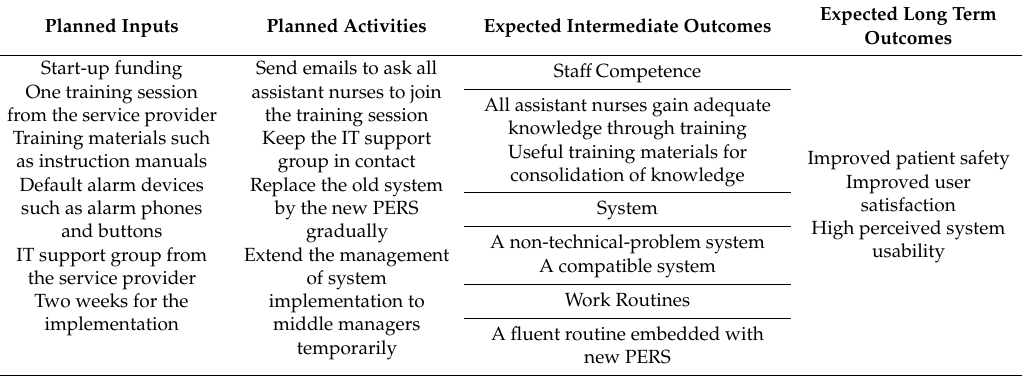
Table 3. Planned inputs and activities and expected outcomes according to the logic